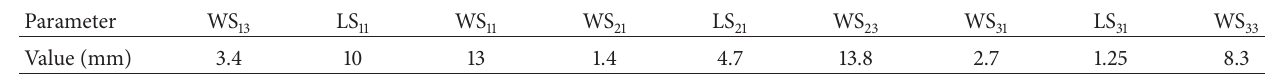
Table 1: The optimized dimensions of the slots investigated in the proposed antenna.